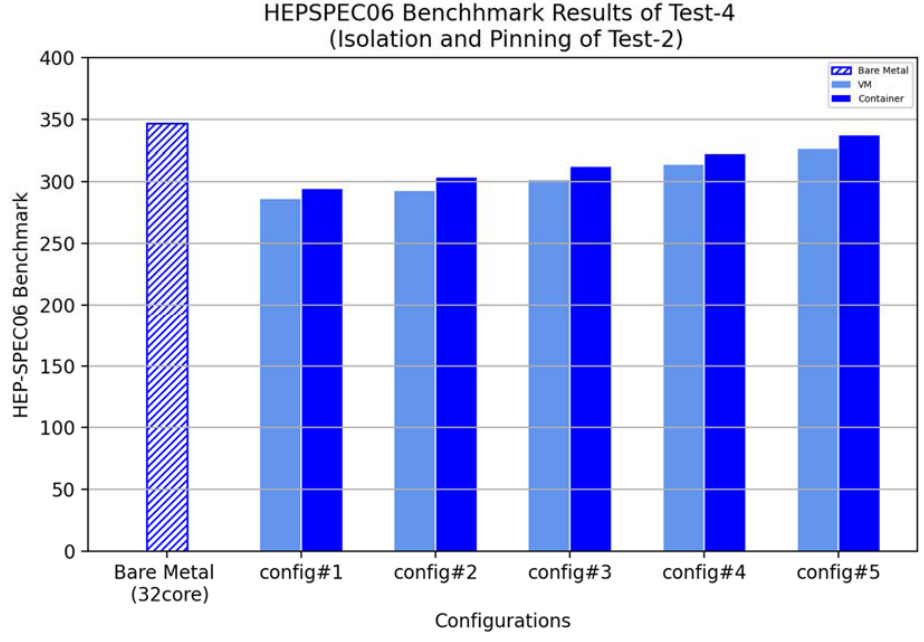
Figure 5. HEPSPEC06 benchmark results of test ‐ 4.